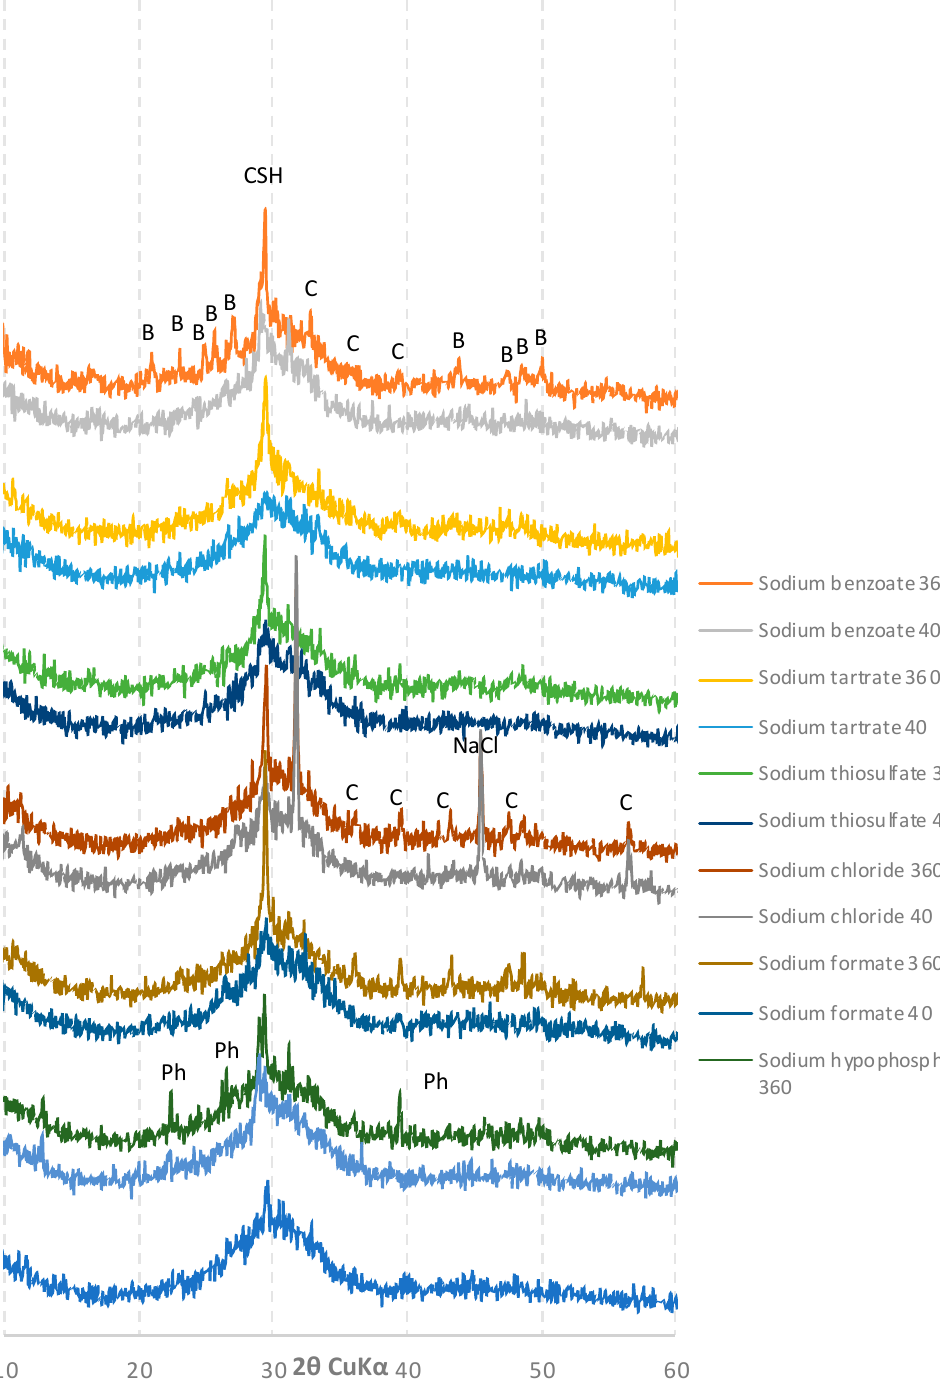
Figure 8. Diffractograms of slag activated with sodium benzoate, tartrate, thiosulfate, formate, chloride and hypophosphite after 40 and 360 days of curing: CSH —calcium silicate hydrates; B —sodium benzoate; C —calcite; NaCl —sodium chloride; Ph —sodium phosphate.